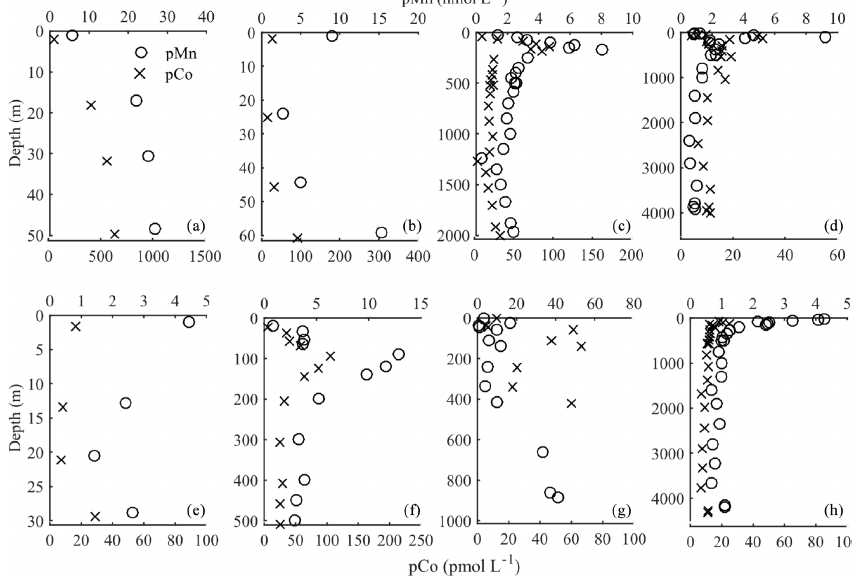
Figure 7. Particulate manganese (pMn; open circles) and particulate cobalt (pCo; × ) from several stations along the northern (a–d) and southern (e–h) legs of the transect, with the same station designations as in Fig.